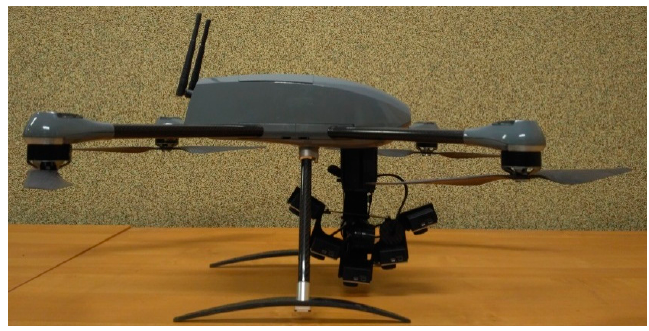
Figure 1. The multirotor platform adapted to carry the multi-camera system.